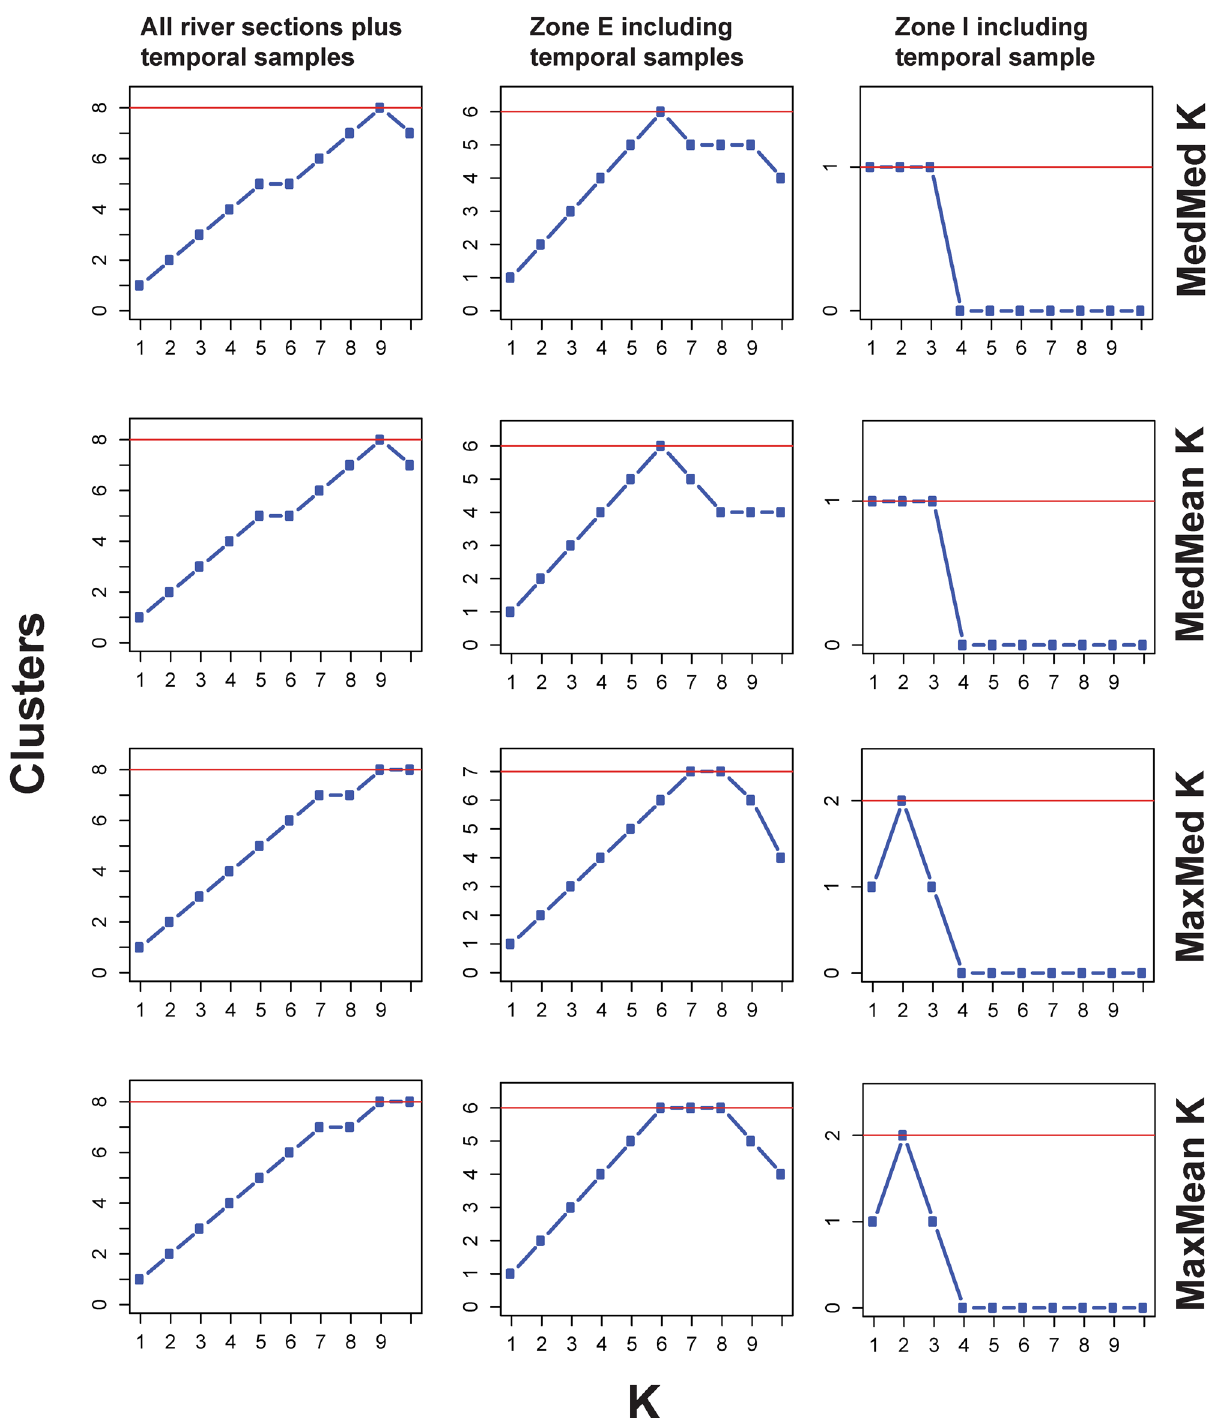
Figure 2. STRU CTU RESELECTOR results. Here, we show only runs without use of the LOCPRIOR option; runs for which the LOCPRIOR option was used can be found in the supplementary material. Left panel: STRU CTU RESELECTOR results for the entire data set (i.e., all main river zones plus temporal samples), middle panel: STRU CTU RESELECTOR results for zone E, right panel: STRU CTU RESELECTOR results for zone I. The four different estimators introduced by 54 are listed on the right-hand side. The most likely number of genetic clusters is indicated by a red